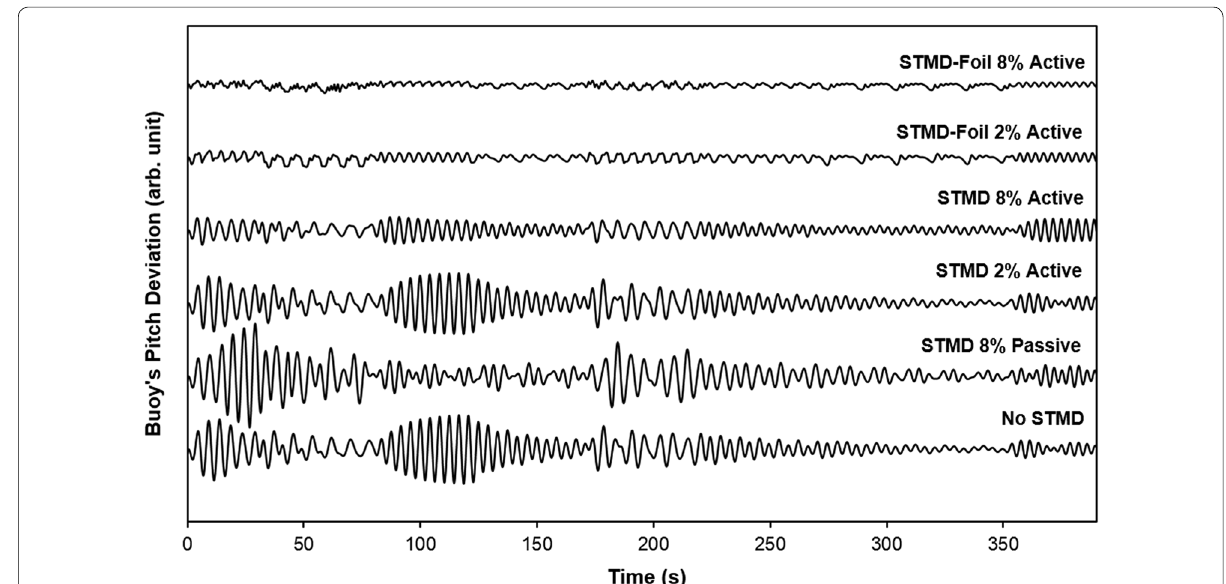
Fig. 16 Time-domain response of the buoy with different control strategies Buoy’s pitch deviation with proposed control strategies in response to a series of continuous waves with different heights and periods is presented